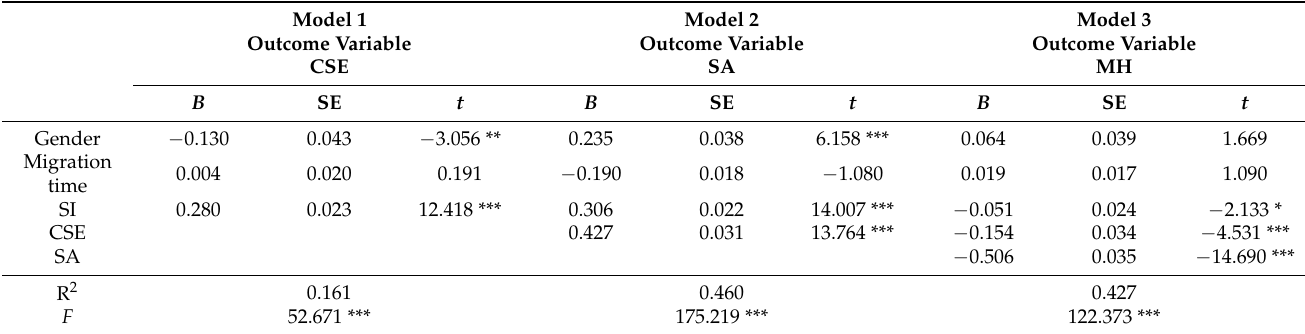
Table 3. Regression analysis of the association between study